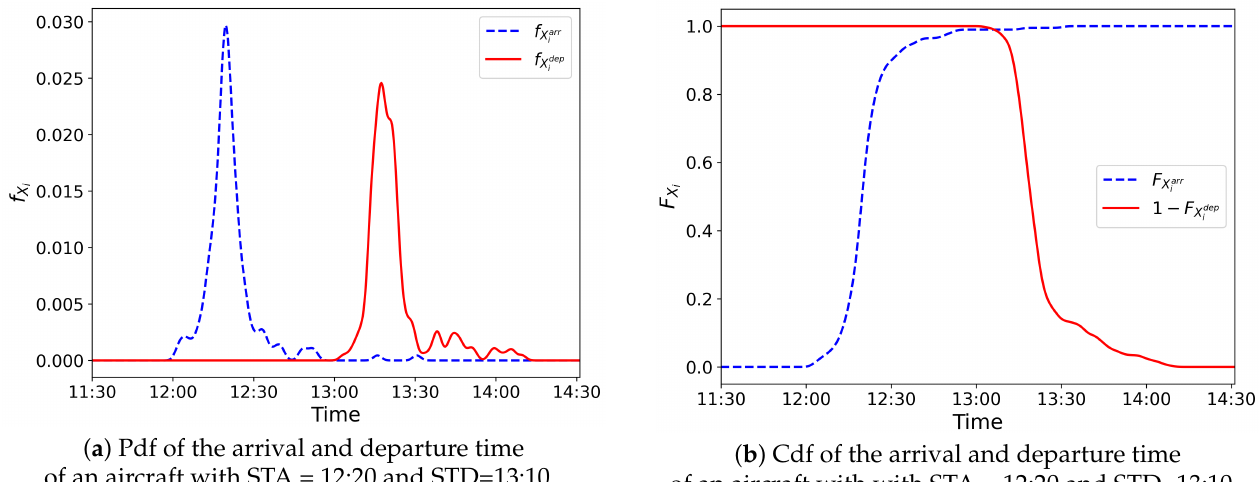
Figure 7. Probability density function and cumulative distribution functions of arrival and departure times for an exam- ple